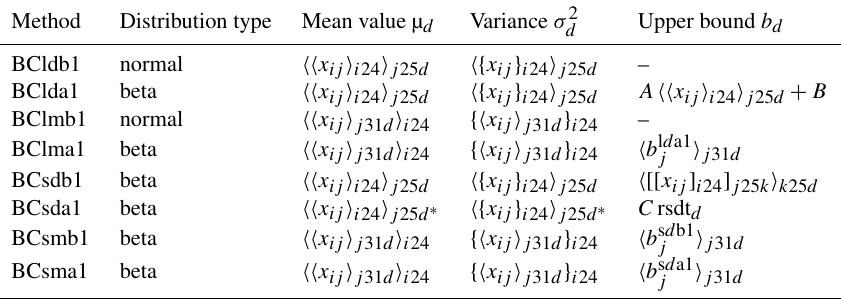
Figure 1. Estimation of parameters of quantile mapping methods used for the bias correction of longwave ( a, b ) and shortwave ( c, d ) radiation at the daily ( a, c ) and monthly ( b, d ) timescales. This example is based on SRB daily mean rlds and rsds data from 79.5 ◦ N, 12.5 ◦ E and the December 1983–November 2007 time period. Climatological distribution parameters are estimated based on empirical 24- year mean values (dark grey), standard deviations (light grey range around mean values), and minimum and maximum values (black) of daily mean ( a, c ) and 31-day running mean ( b, d ) radiation computed for every day of the year. The distribution parameters estimated for the basic (red) and advanced (blue) bias correction methods (see Table 1) include mean values and standard deviations (dotted red, dashed blue), and upper bounds (solid red, solid blue) where beta distributions are used. Note that the basic and advanced estimates of mean values and standard deviations only differ in panel ( c ) near the beginning and end of polar night (see Table 1). The green line in panel ( a ) represents 25-day running mean values of 25-day running maximum values of 24-year maximum values of daily mean rlds, which are used to estimate the upper bounds of the climatological beta distributions used by the BClda1 method (solid blue line in panel a ). The lower bounds of all climatological beta distributions are set to zero. Table 1. Distribution types and parameter estimation methods of bias correction methods BC vtp 1 for day d of the year (see Fig. 1). Please note that the lower bounds of all climatological beta distributions are set to zero and that 24-year statistics are replaced by 12-year statistics for cross